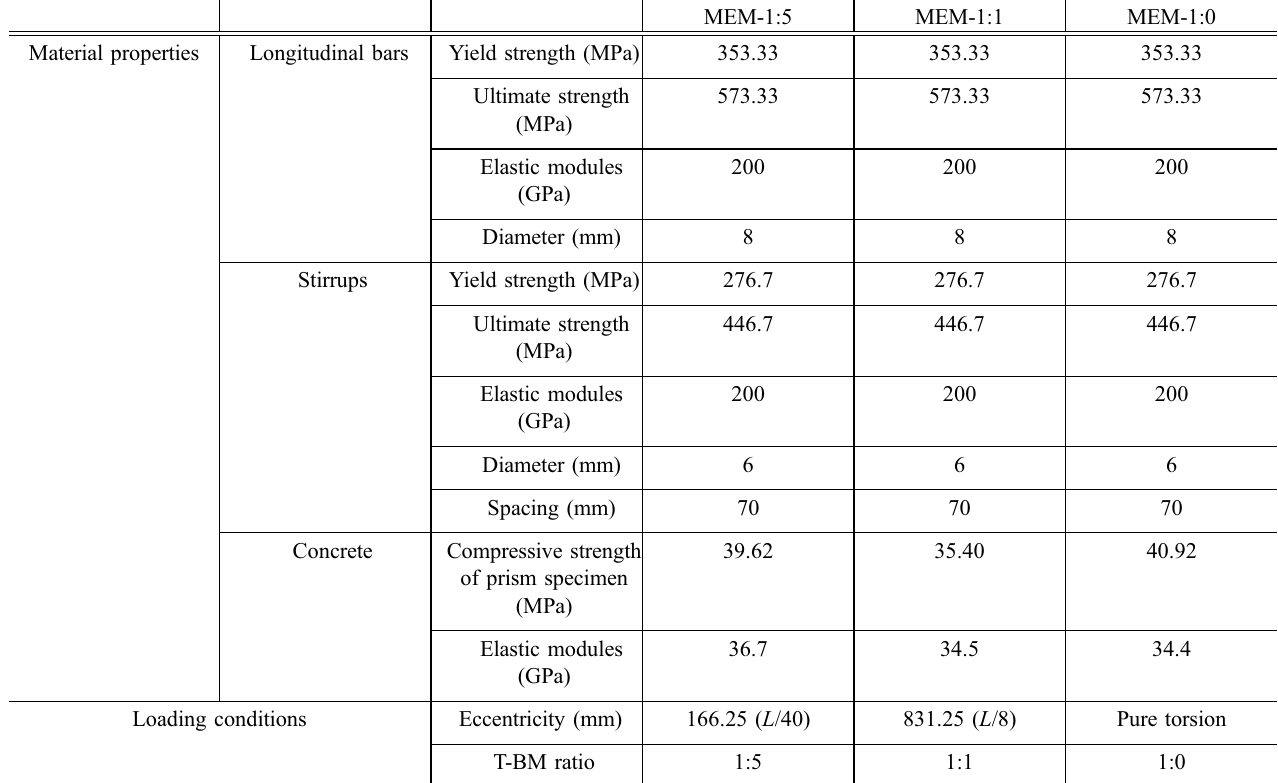
Table 1 Material properties and loading conditions of beam